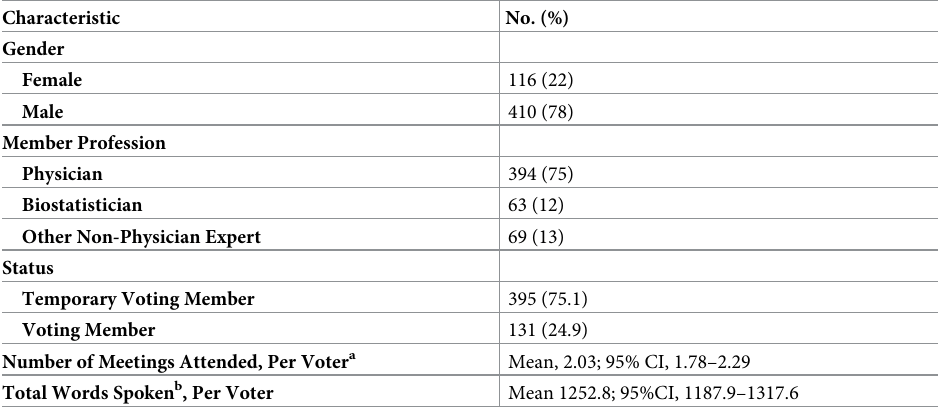
Table 1. Characteristics of voting members (N =